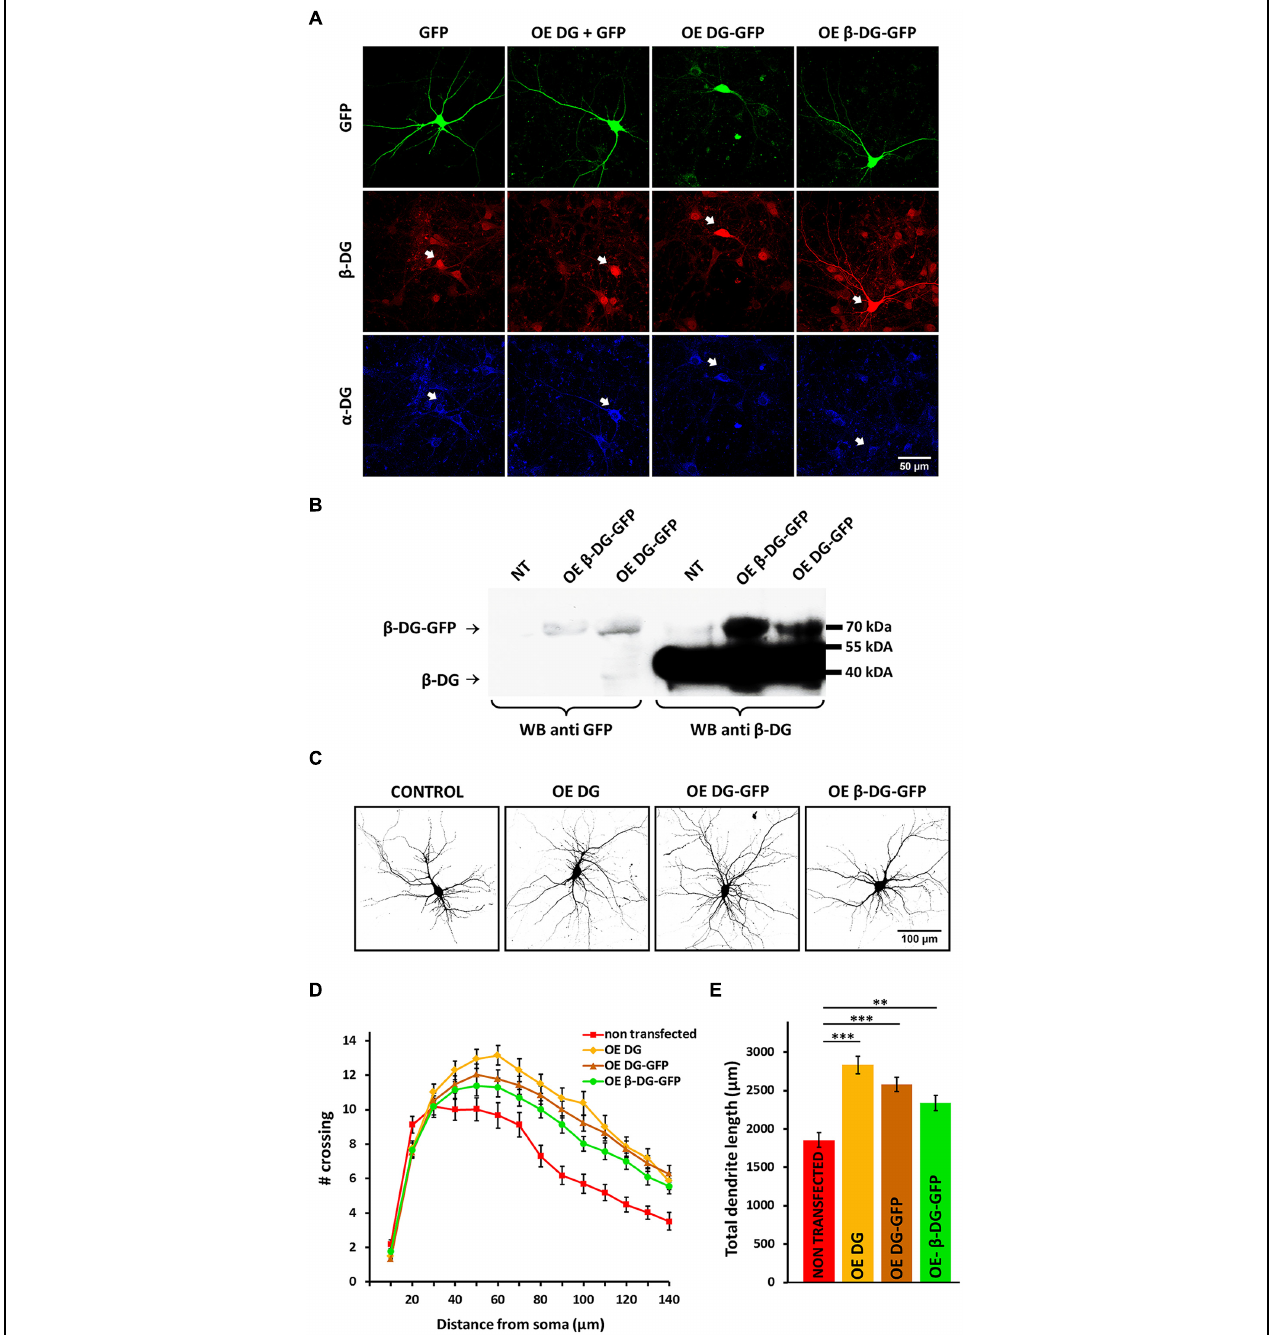
FIGURE 2 | Overexpression of DG stimulates dendritic outgrowth and arborization. (A) The upper panel shows confocal images of hippocampal neurons transfected with a GFP-coding vector (GFP) or vectors used for DG overexpression: OE DG (co-transfected with GFP), OE DG-GFP, and OE β -DG-GFP (green). The lower panels show α -DG (blue) and β -DG (red) immunofluorescence staining of cells in the same fields. The arrowheads indicate transfected cells. (B) Immunoblot analysis of GFP and β -DG expression in cortical neurons after nucleofection with either OE DG-GFP or OE β -DG-GFP plasmid. Non-transfected cells (NT) served as a control. (C) Representative images of neurons used for the